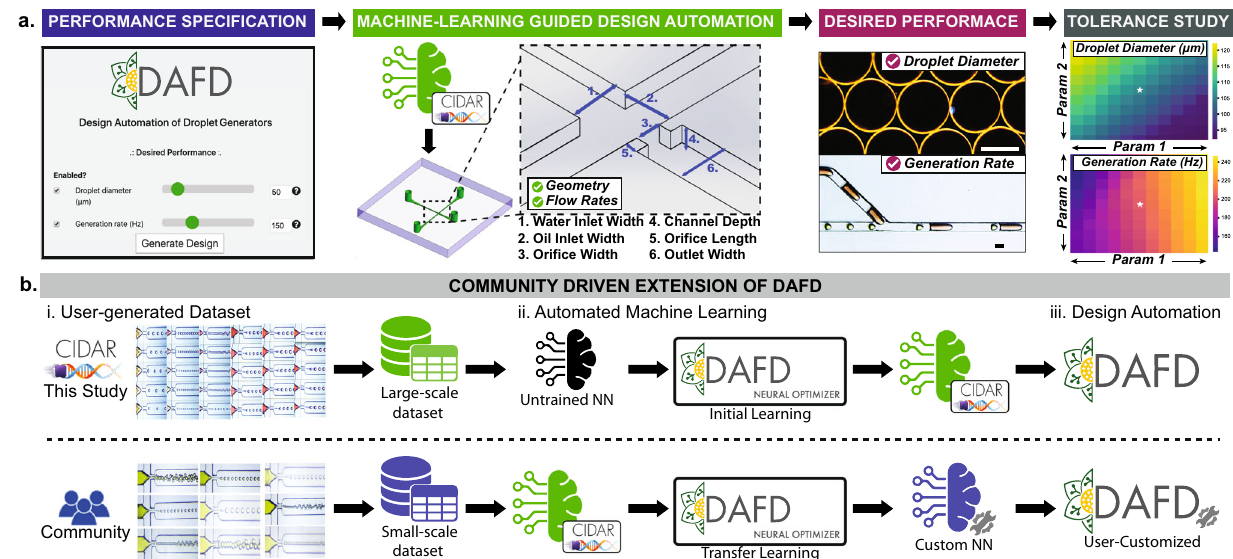
Fig. 1 The work fl ow of the developed design automation tool for fl ow-focusing droplet generators, called DAFD. This tool is made possible by accurate machine learning based predictive models developed in this study. a The machine learning algorithms convert the user-speci fi ed performance into the required geometry and fl ow rates to achieve the desired droplet diameter and generation rate. The developed tool can also predict performance deviations caused by possible tolerances in fabrication or testing. b Accurate predictive models (neural networks with CIDAR logo) trained on a large-scale data-set (initial learning) are made possible by machine learning and a low-cost rapid prototyping method that enabled ef fi cient generation of a large-scale data-set in this study. Additional custom-built design automation tools that support further fl uid combinations can be developed by the micro fl uidic